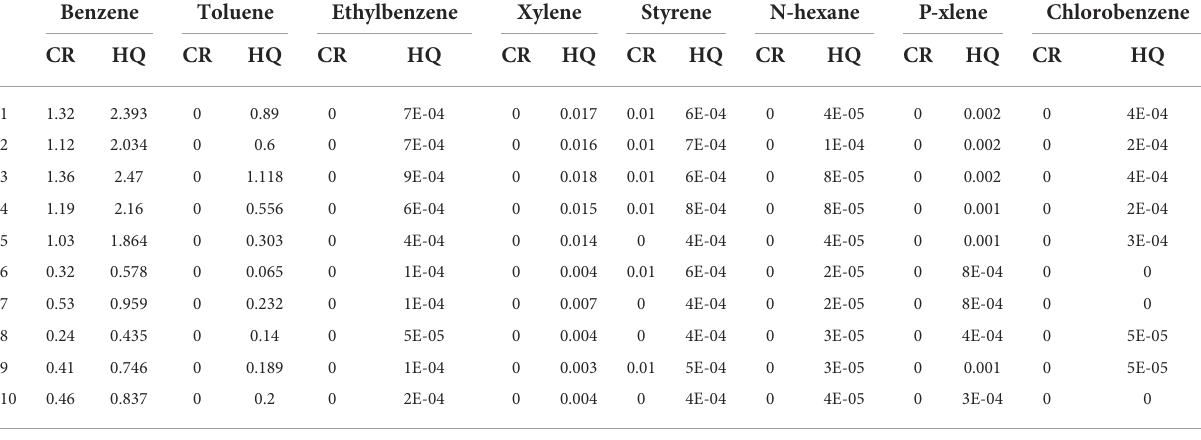
TABLE 11 The evaluated results for cancer risk (CR) and non-cancer risk (HQ) levels.